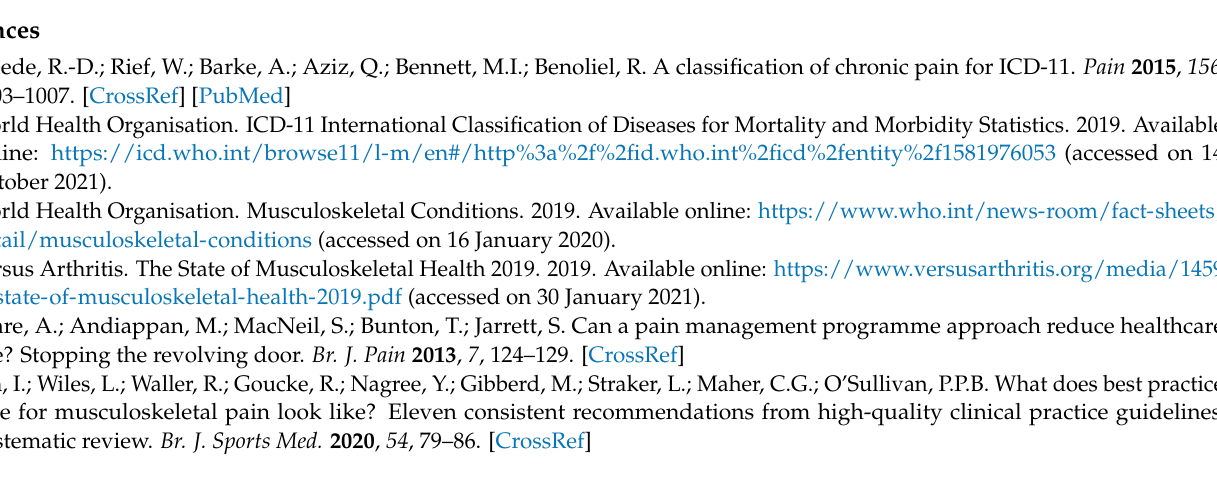
Paragraph S1 additional themes, subthemes and codes within the